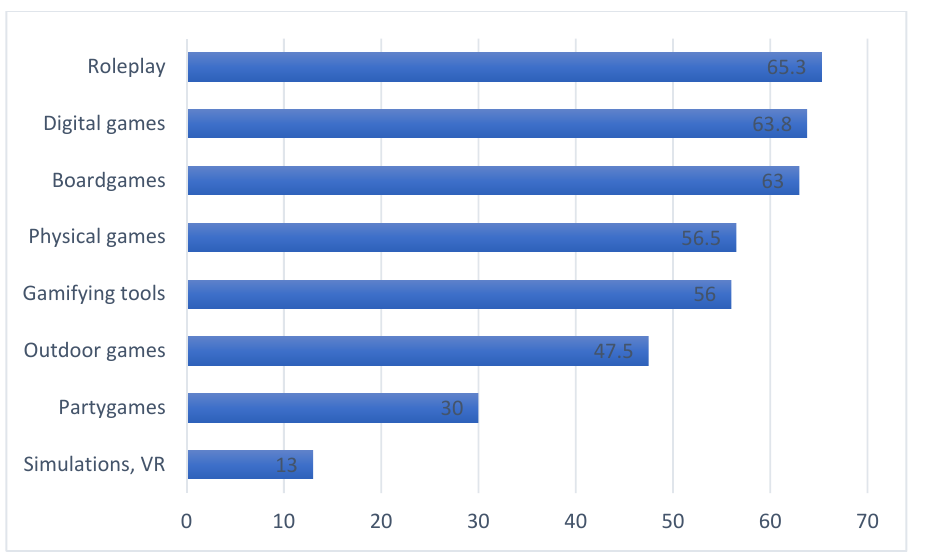
Figure 1. Game genre percentage.